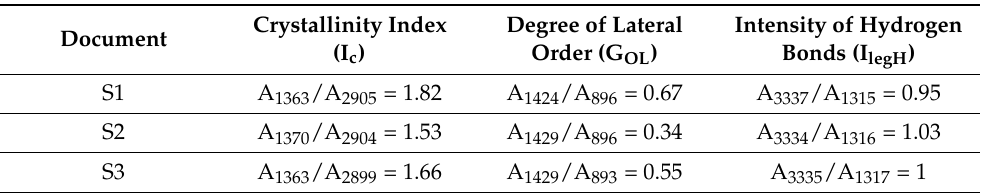
Table 2. Crystallinity indices, degree of lateral order and intensity of hydrogen bonds calculated based on the FTIR spectra.